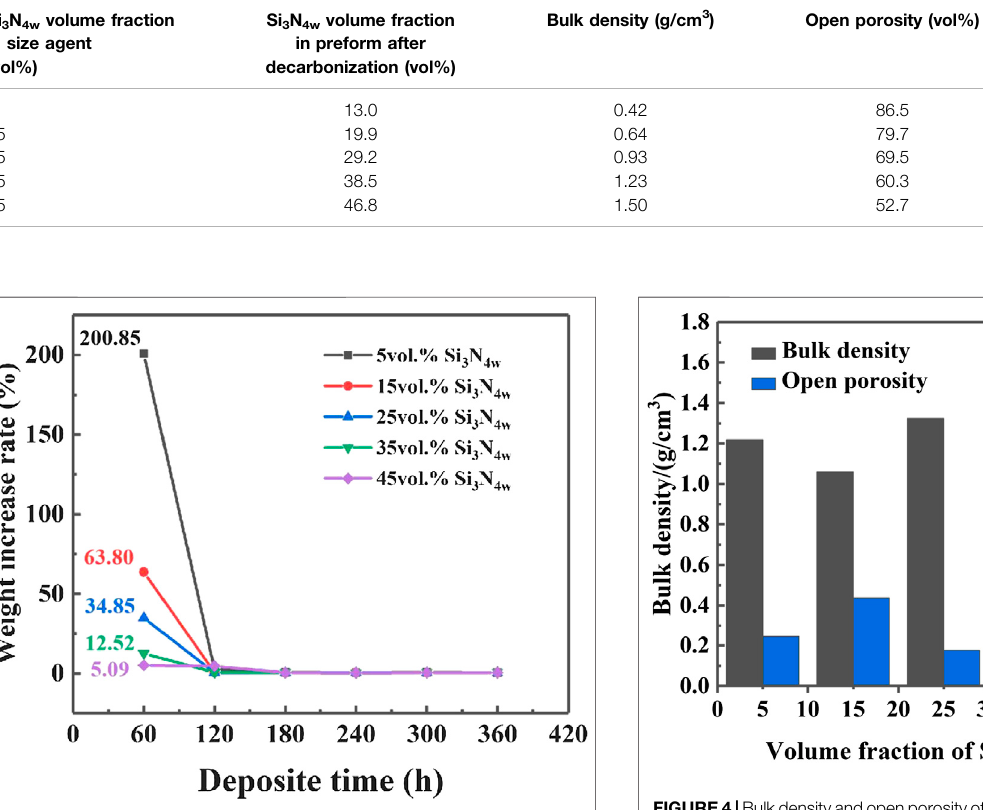
FIGURE 3 | Weight increase rate of fi ve kinds of Si 3 N 4w /Si 3 N 4 .